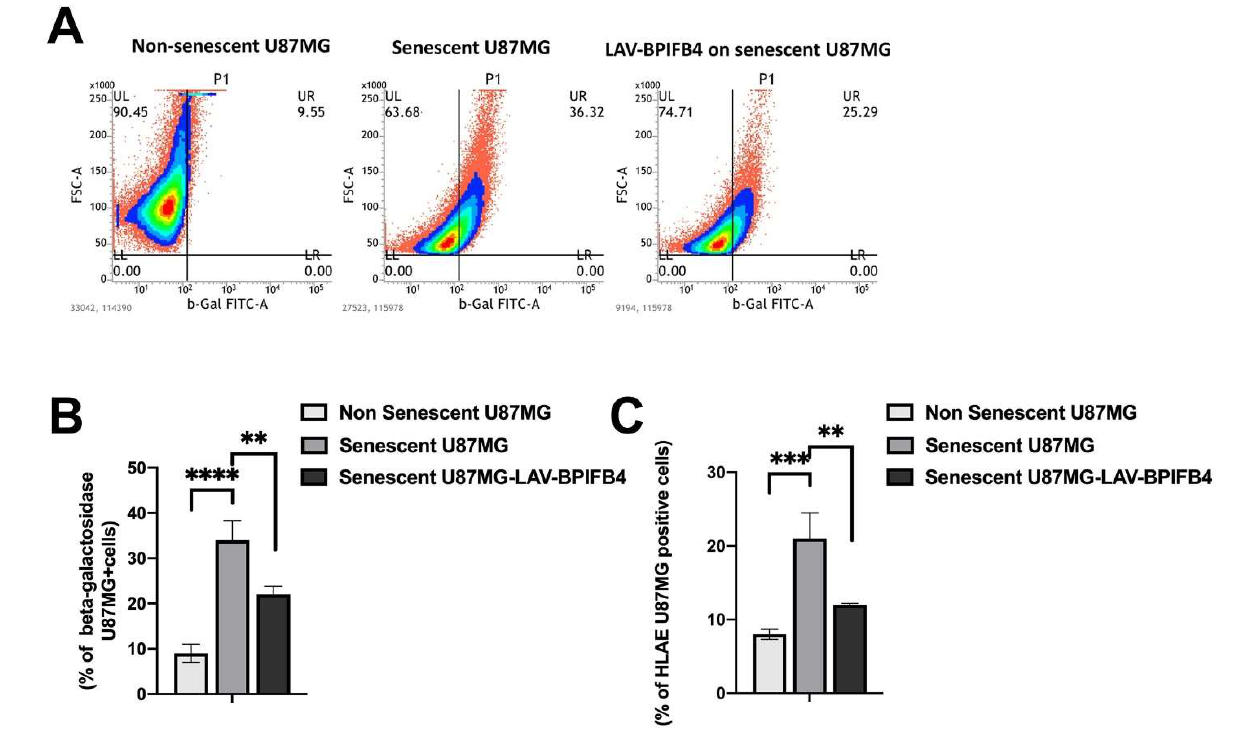
Figure 1. Senescence analysis in the U87-MG glioblastoma cell line. Cytofluorometric analysis of Spider- β galactosidase (spider- β Gal), common senescence marker, in the U87-MG glioma cell line after 24 h of treatment with etoposide (6 μM) and 5 days resting in the presence or absence of 18 ng/mL of rhLAV-BPIFB4 for the last 48 h. The treatment with etoposide induced senescence as shown in ( A ) (middle graph); after the treatment with 18 ng/mL of rhLAV-BPIFB4 the spider- β Gal values decreased (right graph in ( A )). ( B ) Bar graph reporting the mean percentage values ± SD of β galactosidase viable cells from 3 independent experiments. ( C ) Cytofluorimetric analysis of the HLA-E expression on U87-MG cells’ surfaces in the control and in ETP-treated cells with or without rhLAV-BPIFB4 for the 5 days resting as indicated in Section 2. The bar graphs report the mean ± SD of the percentage of positive cells in the different conditions. Statistical analysis by two-way ANOVA with Tukey’s test for multiple comparison was conducted. (** p < 0.001, *** p < 0.0001, **** p <